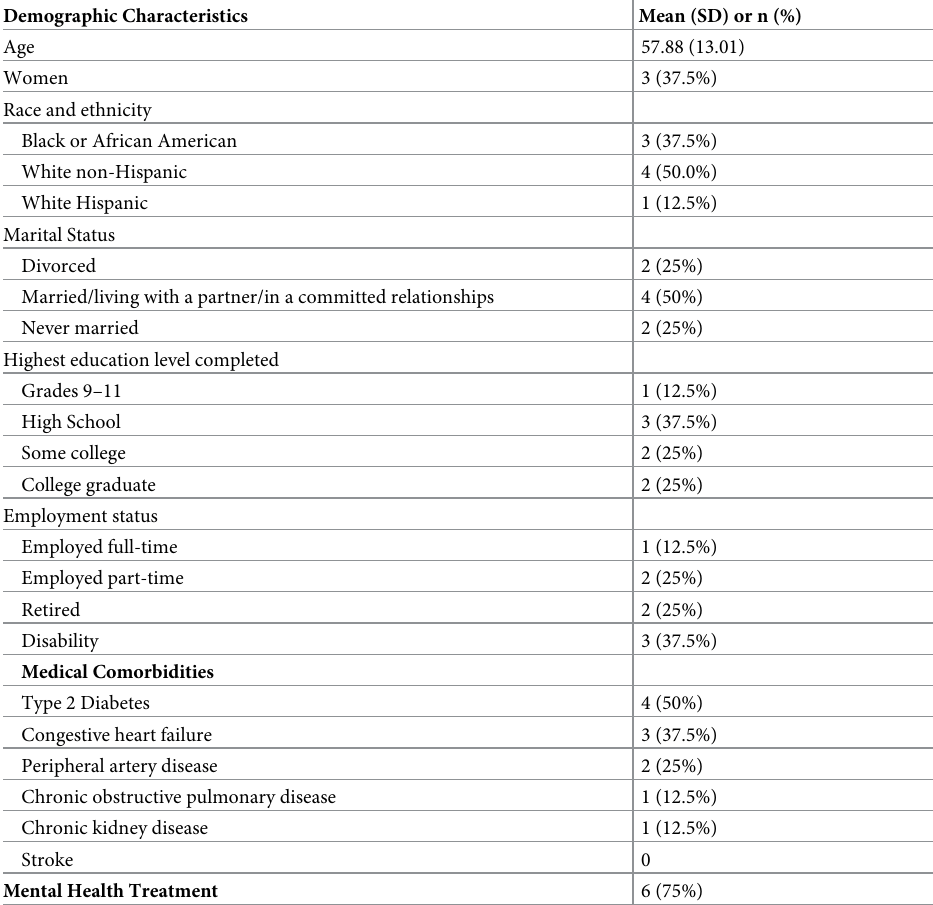
Table 3. Open pilot trial participant characteristics at baseline (n =